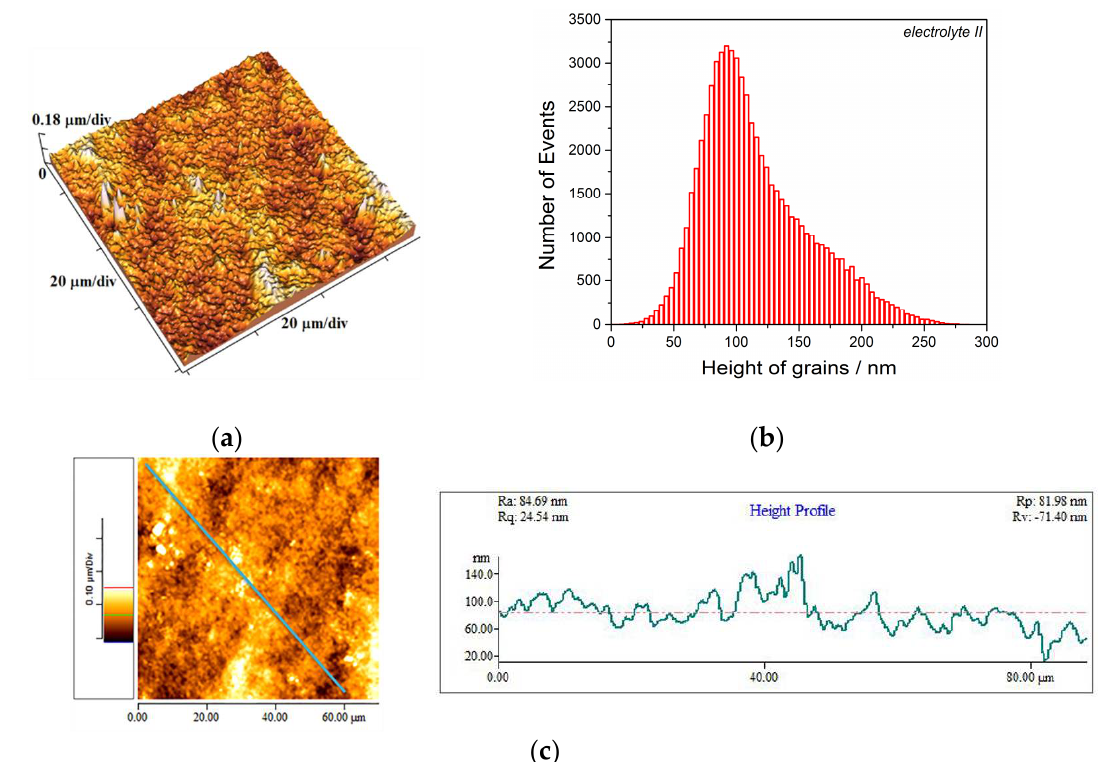
Figure 5. The AFM analysis of 20 µm thick Cu coating obtained by electrodeposition at a current density of 50 mA cm -2 on the Si(111) substrate from electrolyte I : ( a ) the surface topography, ( b ) the histogram and ( c ) line section analysis (X-axis: distance line; Y-axis: height profile). Scan size: (70 × 70) µm 2 .